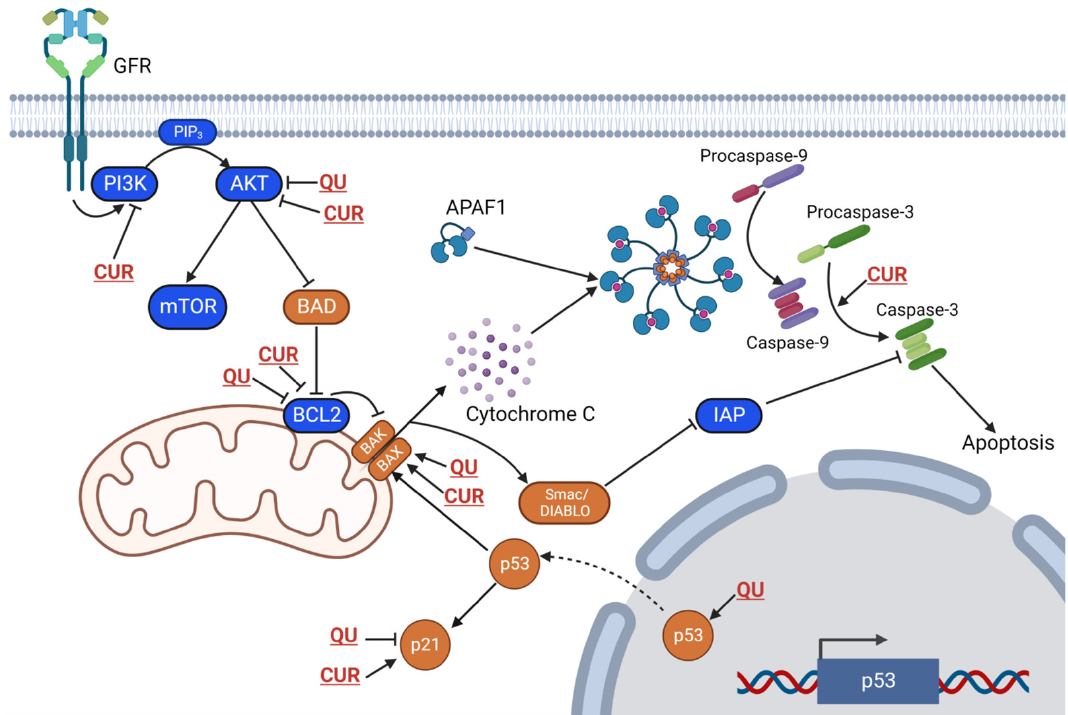
Figure 4. Signaling pathways modulated by quercetin and curcumin to induce tumor suppression and apoptosis. QU, quercetin; CUR, curcumin.